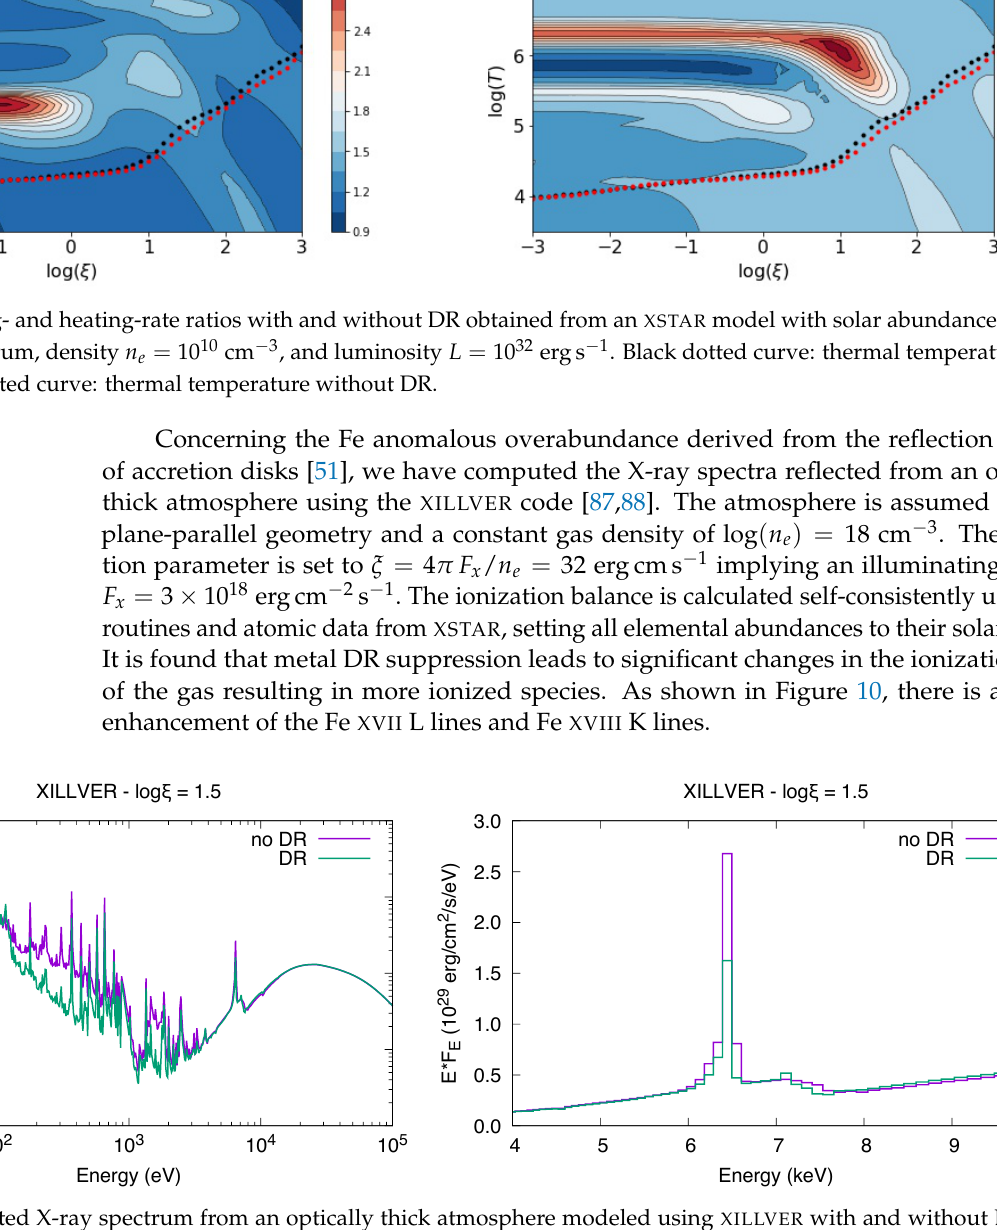
Figure 10. Reflected X-ray spectrum from an optically thick atmosphere modeled using XILLVER with and without DR. A plane-parallel atmosphere with solar abundances and density log ( n e ) = 18 cm − 3 was